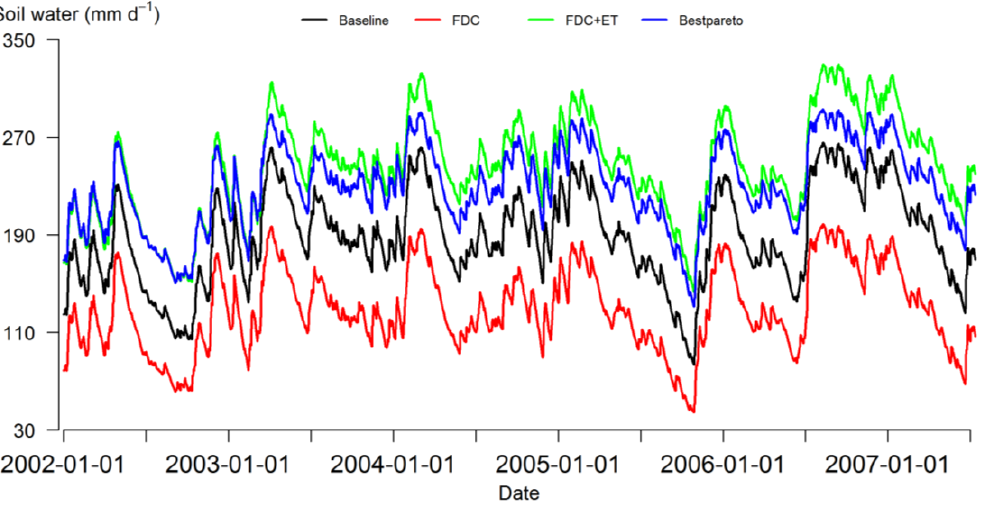
Figure 15. Daily mean basin soil water dynamics as simulated by the baseline and calibrated SWAT models (2002 – 2007). FDC: calibration using only streamflow signature measures; FDC+ET: calibration using streamflow signature measures and remote sensing evapotranspiration; BestMO: automatic multi-objective calibration based on selected best parameter set from the Pareto set solutions.